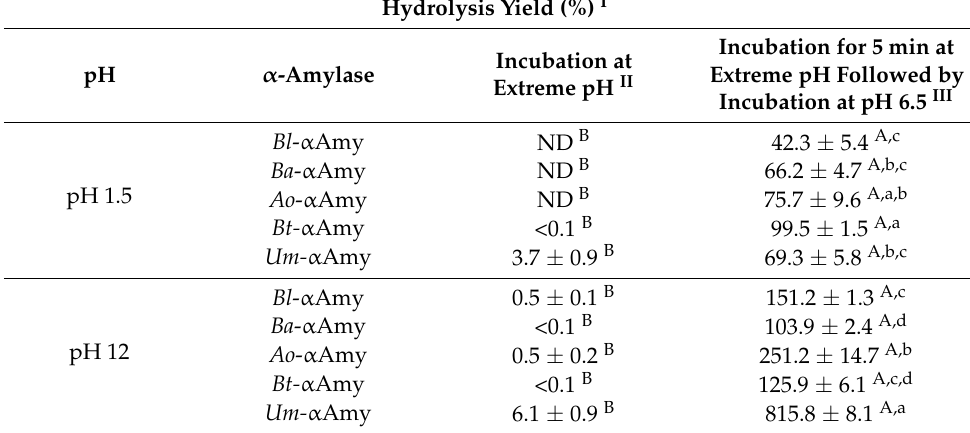
Table 2. Inactivation of five distinct α -amylases using pH 1.5 and 12. I ratio between the reducing sugar concentration in supernatants of 15 % raw potato starch samples incubated for 16 h with each of the five α -amylases at different pH values (S) and the respective controls (C)—i.e., the reducing sugar concentration in supernatants of starch treated with each of the five α -amylase